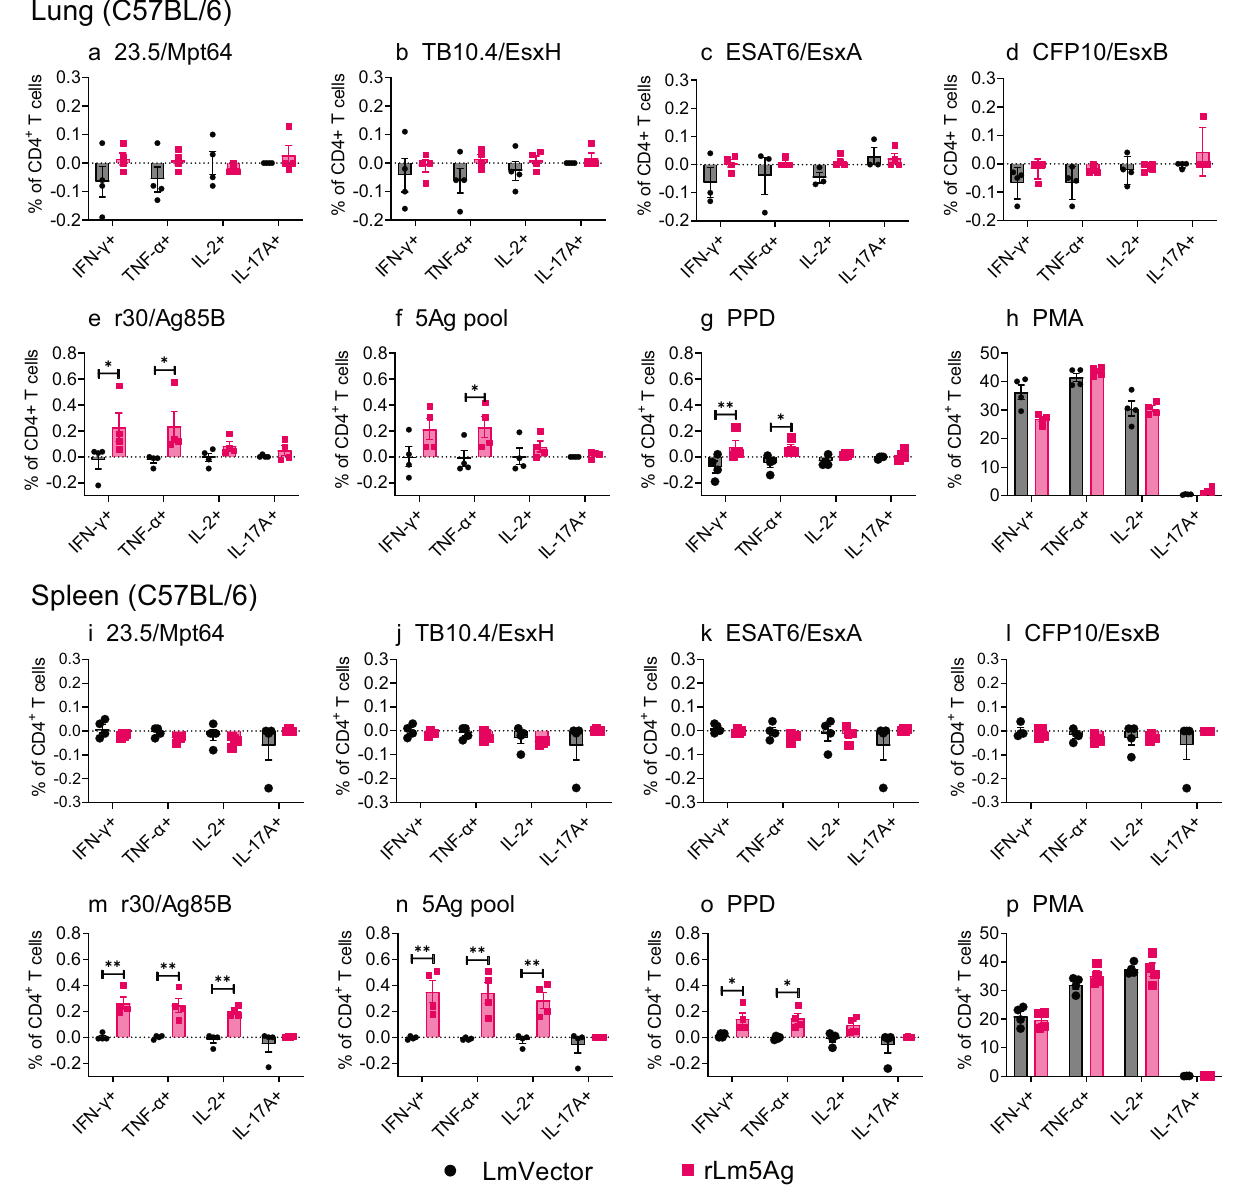
Fig. 2 Frequency of cytokine-expressing CD4 + T cells in the lungs and spleens of C57BL/6 mice immunized three times with LmVector or rLm5Ag. C57BL/6 mice ( n = 4/group) were immunized s.q. three times with LmVector (black) or rLm5Ag (pink) at Weeks 0, 4, and 8. Six days after the last immunization, mice were euthanized; their lungs and spleens removed; single cell suspensions prepared and stimulated with individual proteins of 23.5/ Mpt64 ( a , i ), TB10.4/EsxH ( b , j ), ESAT6/EsxA ( c , k ), CFP10/EsxB ( d , l ), r30/Ag85B ( e , m ), or pool of 5 antigens (5Ag pool) ( f , n ), or PPD ( g , o ) in the presence of anti-CD28 monoclonal antibody for 6 h; GolgiPlug (protein transport inhibitor containing Brefeldin A) diluted in T-cell medium was added to all wells; additional cells incubated with PMA and Golgiplug for 4 h served as positive control ( h , p ). The cells were assayed by excluding dead cells followed by staining for surface markers of CD4 and CD8 followed by CD3 and intracellular markers of IFN- γ , TNF- α , IL-2, and IL-17A, as indicated below each panel. Frequencies of live CD4 + T cells expressing any of the four cytokines were analyzed by FlowJo 10 software. Values are the mean ± standard error of the mean (SEM). * P < 0.05; and ** P < 0.01 by two-way ANOVA with Sidak ’ s post multiple comparisons test. A similar experiment was repeated in C57BL/6 pool (Figs. 4f and 5c), and PPD (Figs. 4g and 5d) than mice CD4 + T cells expressing any of the cytokines were detected after immunized with LmVector in the lung, and a greater frequency of in vitro stimulation with 23.5/Mpt64 (Fig. 2a, i), TB10.4/EsxH CD8 + T cells expressing TNF- α in response to the 5Ag pool in (Fig. 2b, j), ESAT6/EsxA (Fig. 2c, k), or CFP10/EsxB (Fig. 2d, l), the spleen (Fig. 4n). Of note, the frequencies of antigen speci fi c or as expected PMA (Fig. 2h, p). Notably, mice immunized with cytokine-producing CD4 + and CD8 + T cells in the lungs and rLm5Ag also produced greater frequencies of CD8 + T cells expressing IFN- γ and TNF- α and polyfunctional CD8 + T cells spleens after 22-h antigen stimulation were similar to those after expressing both cytokines in response to in vitro stimulation with 6-h stimulation. Thus, homologous priming-boosting C57BL/6 23.5/Mpt64 (Figs. 4a and 5a), TB10.4/EsxH (Figs. 4b and 5b), 5Ag mice with rLm5Ag induces Mtb antigen-speci fi c cytokine-